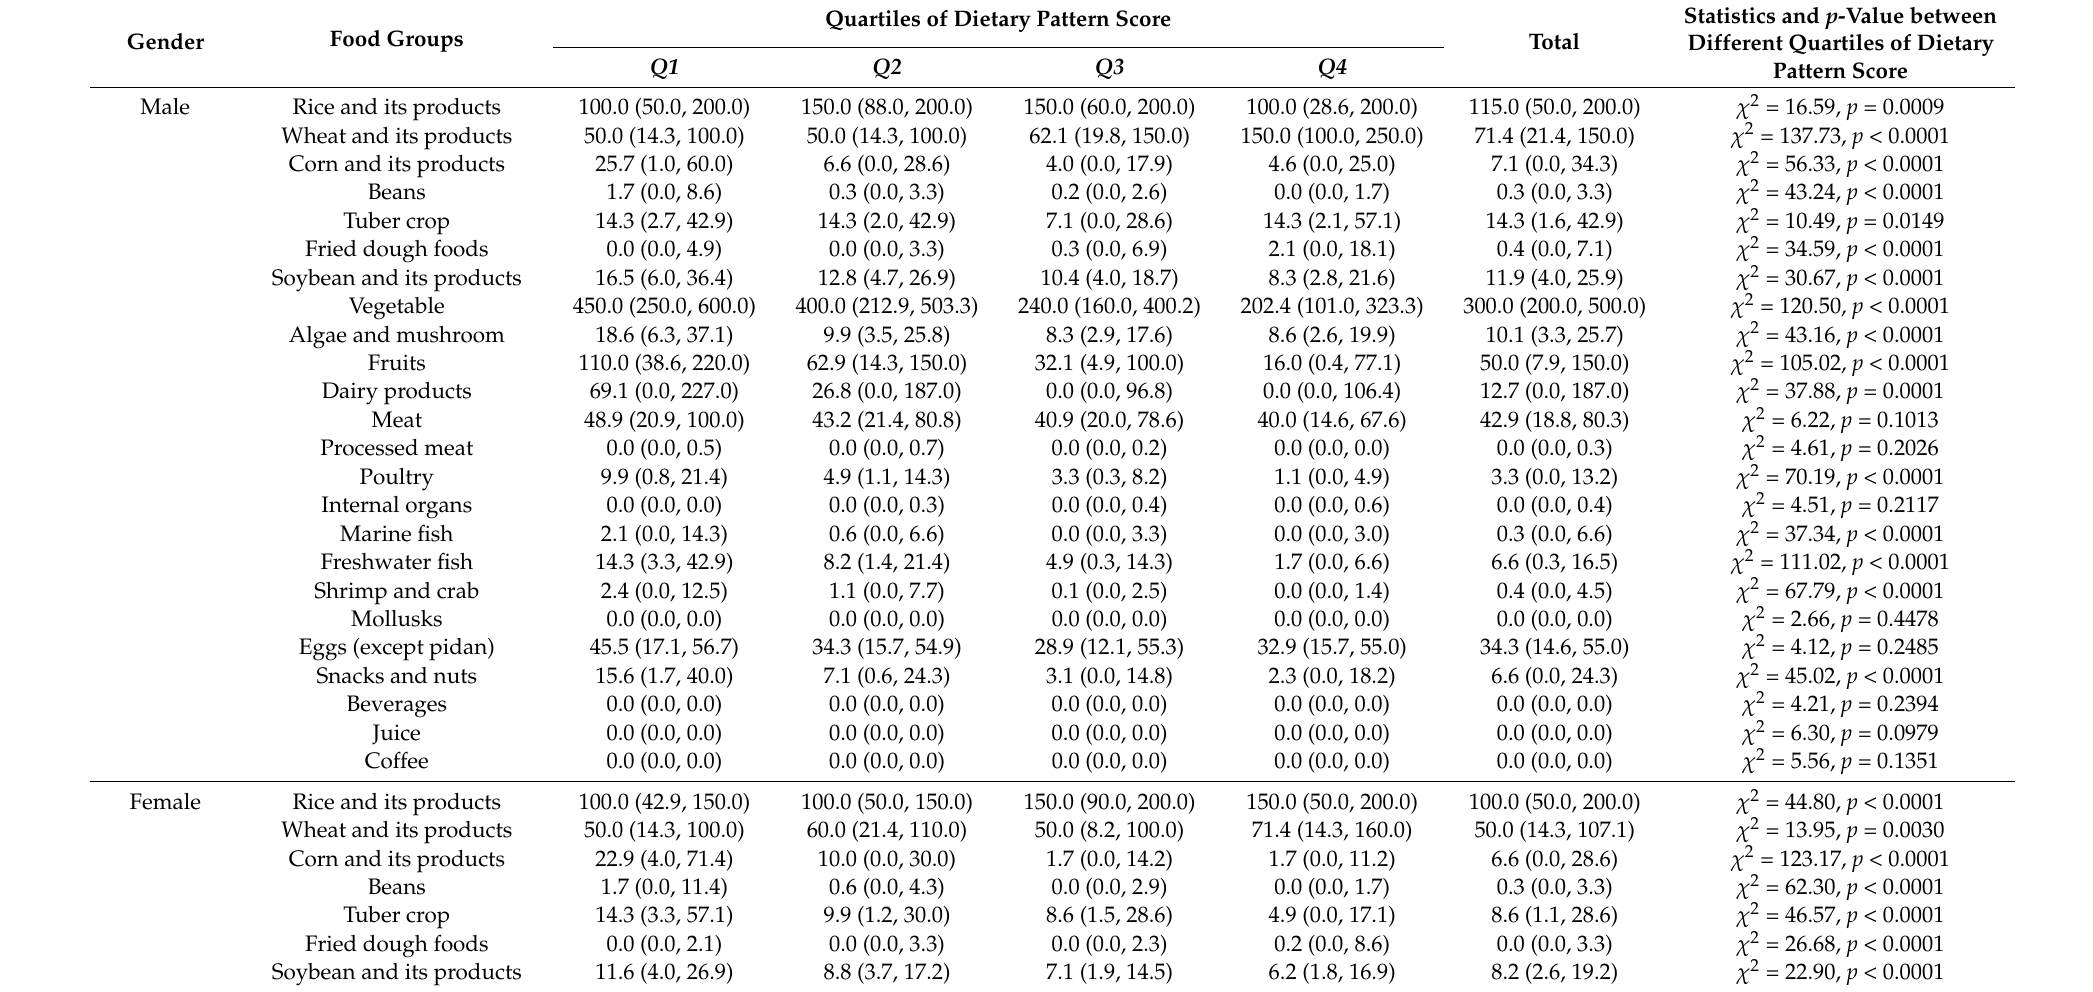
Table 3. Intake of food groups by participants analyzed by quartile levels of dietary-pattern scores in this study (M (P 25 , P 75 ),